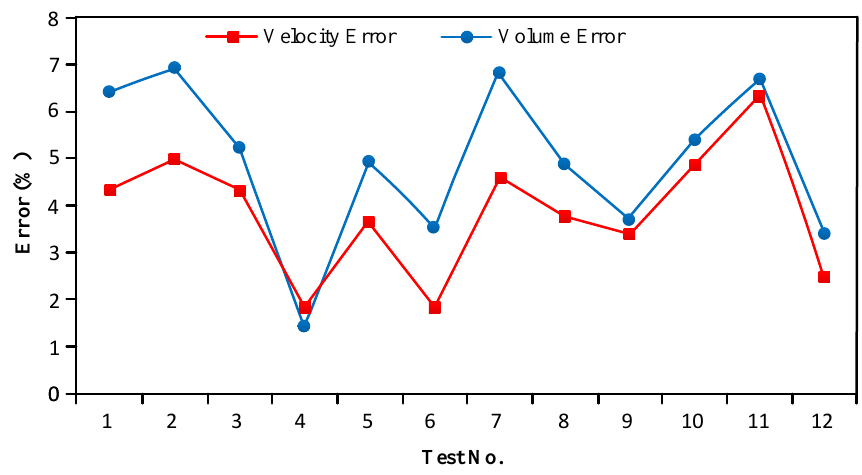
Figure 9. Relationship between the velocity measurement and volume measurement errors.